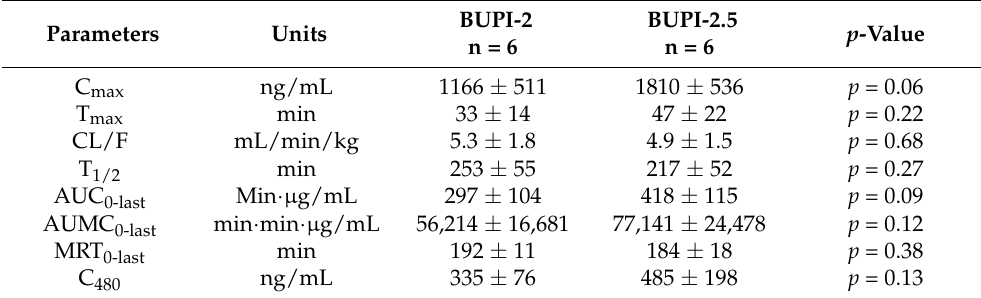
Table 2. Mean ± SD pharmacokinetic data for bupivacaine after bilateral transversus abdominis plane injection of 2 mg/kg or 2.5 mg/kg (BUPI-2 and BUPI-2.5, respectively) in twelve cats (n = 6/group). Parameters Units